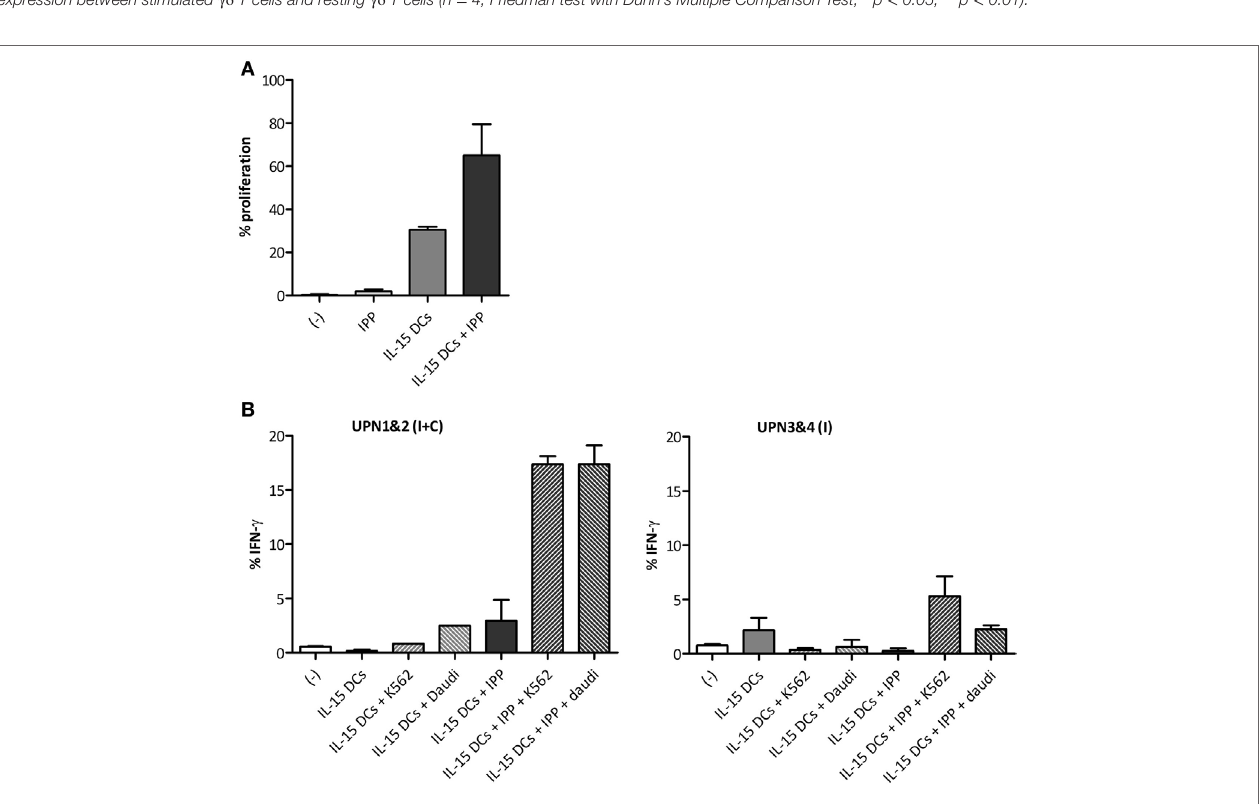
Δ MFI, difference in mean fluorescence intensity between the marker and corresponding isotype control. Asterisks indicate a statistically significant difference in cell surface marker expression between stimulated γδ T cells and resting γδ T cells (n = 4; Friedman test with Dunn’s Multiple Comparison Test; * p < 0.05, ** p < 0.01).